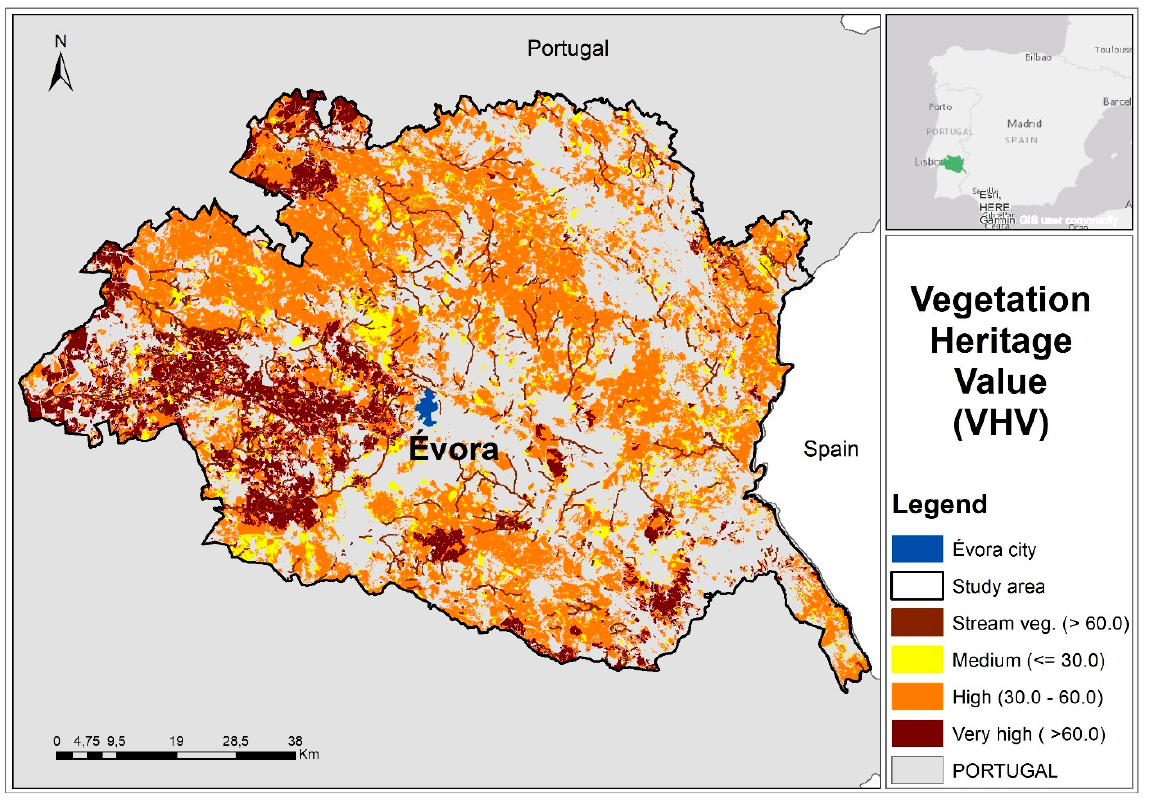
Figure 5. VHV map of the study area (author: T. Batista).